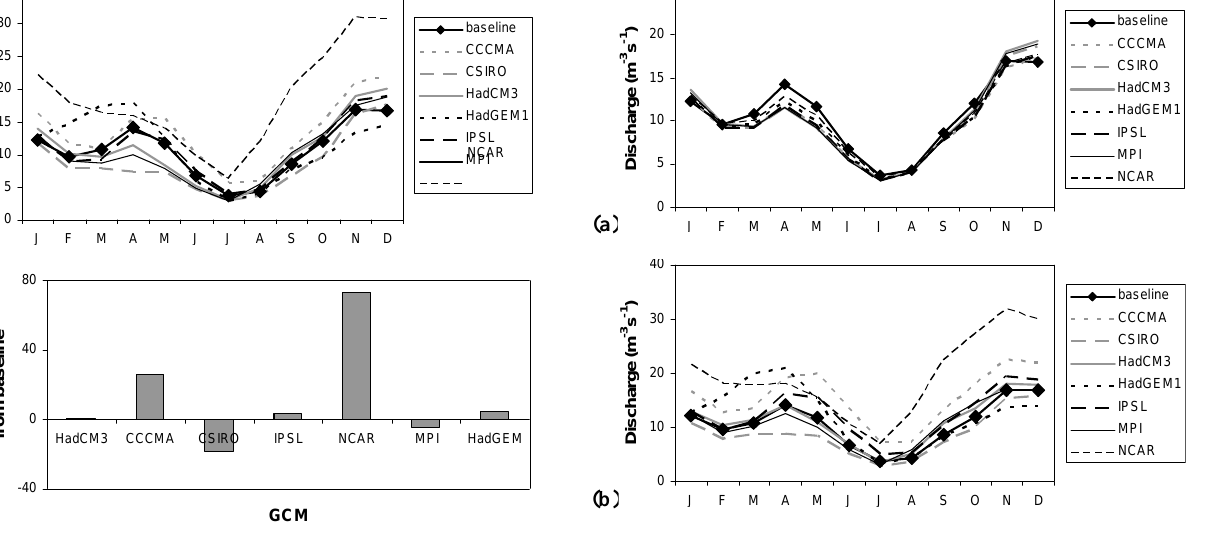
Fig. 8. Climate change signal in (a) monthly and (b) annual Mi- tano discharge under the 2 ◦ C prescribed warming scenario across 7 GCMs.